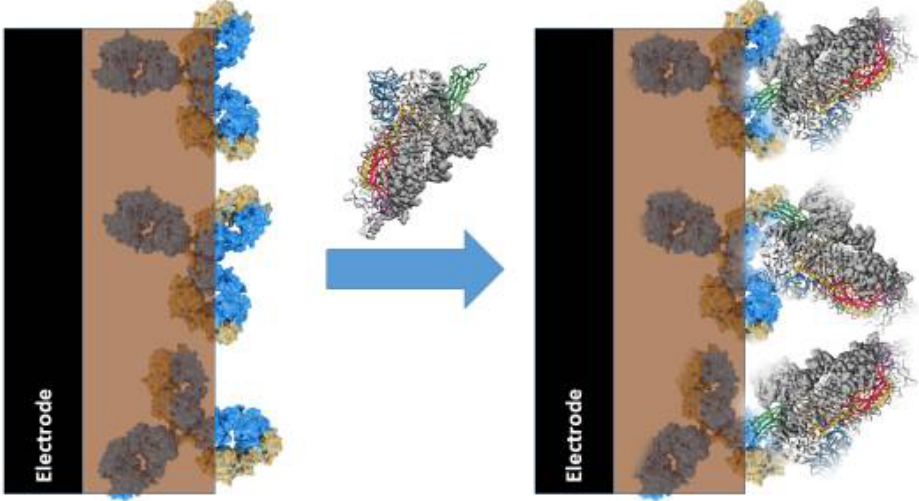
Figure 3. Action of immunosensor based on antibodies immobilized within conducting polymer, polypyrrole, and the formation of the immune complex between immobilized antibodies and analyte-protein (e.g., virus proteins) present in the dissolved aliquot.